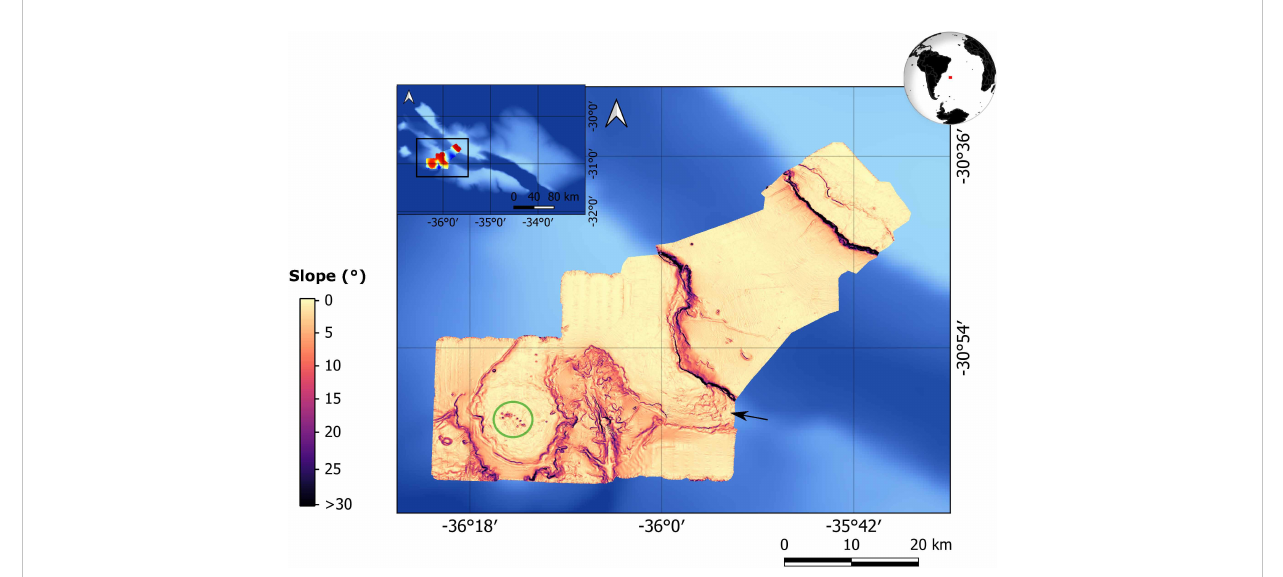
FIGURE 7 Slope map of the study area, in degrees. The green circle highlights circular structures, and the black arrow points to rough terrain, both could be related to crusts.